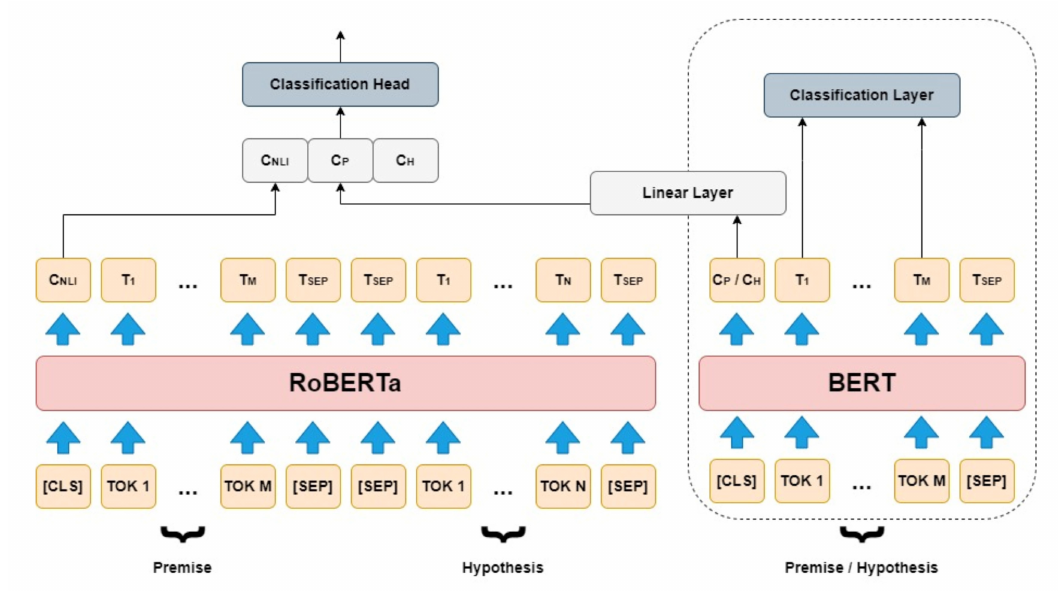
Figure 1. Architecture diagram of predicate-aware RoBERTa